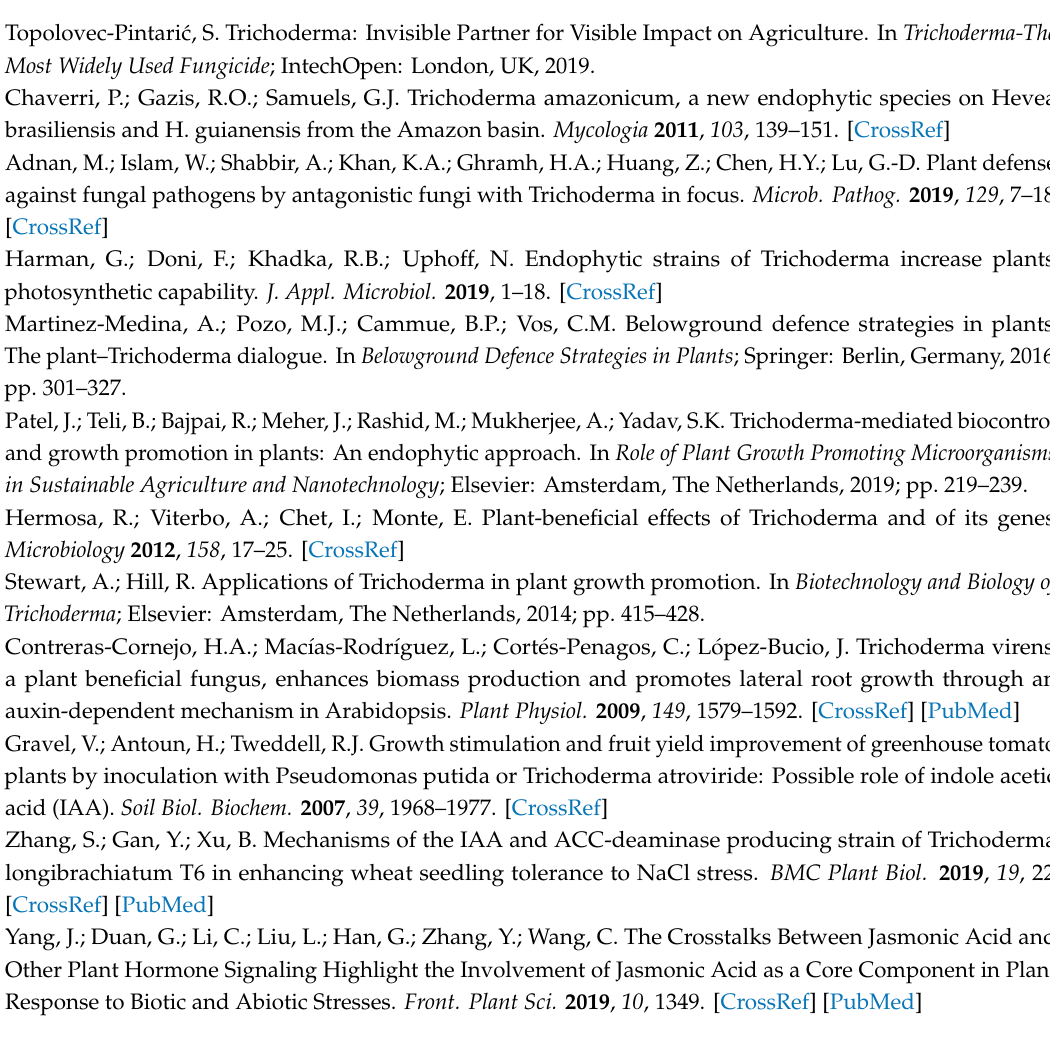
an OX1 plant. Table S1: Data for Figure 2d. Table S2: Data for Figure 4. Table S3: Data for Figure 5. Table S4: All the primers used in this study, Supplementary material 1, the cds of PdPapARF1 showing the fragment used for constructing the RNAi